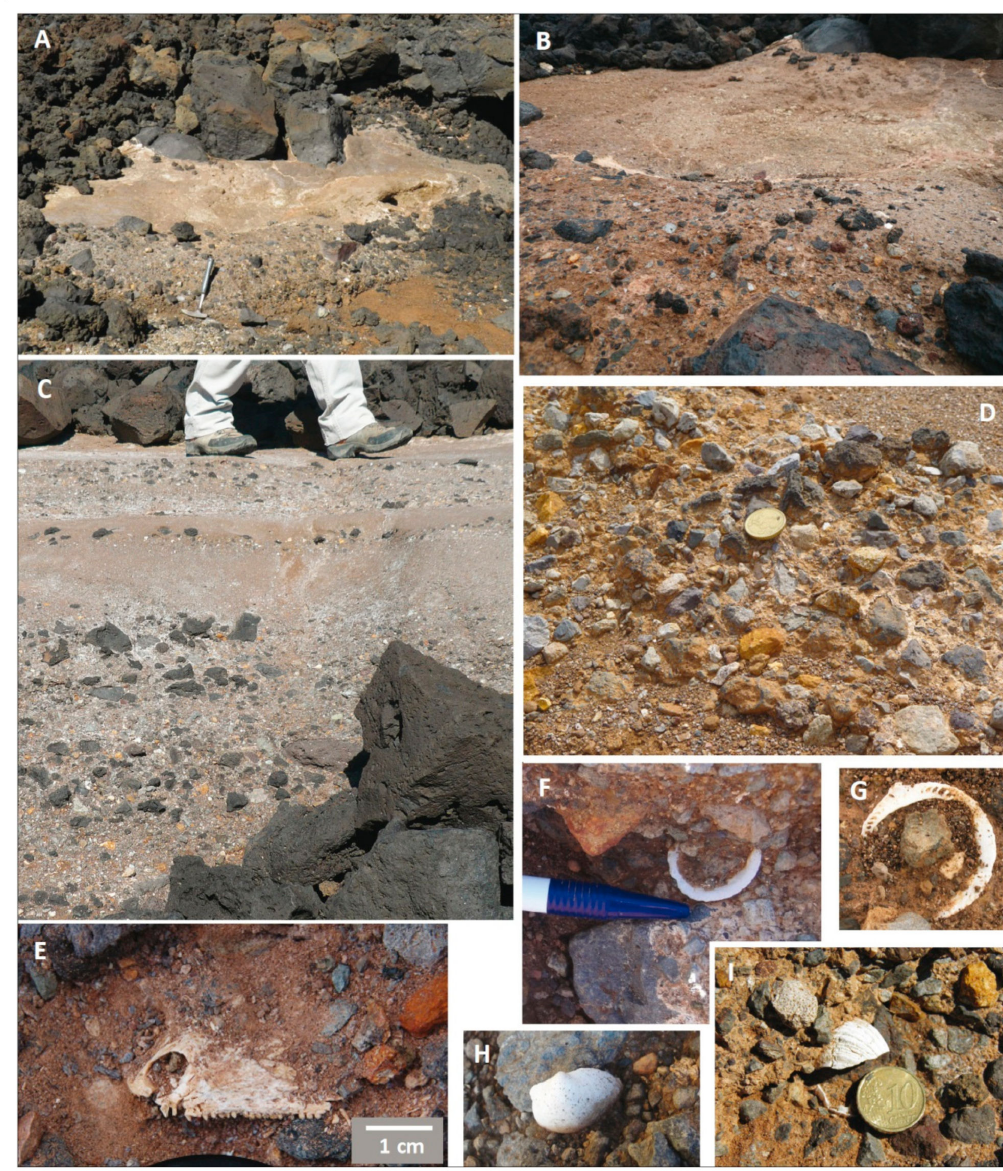
Figure 3. Teno tsunami deposits. ( A – C ) Breccia plastered on in situ basaltic lava close to the seaward edge of the Teno platform, showing normal grading and predominance of pumice in its upper section. The breccia contains abundant larger angular basalt (grey) and smaller light-colored heterolithic clasts dispersed in a sand-sized weathered ash matrix. ( D , I ) Detail of the heterolithic breccia forming the upper unit of the deposit at Teno platform, with matrix to clast-supported fabric, angularity, and poor sorting of clasts, sand-sized ash matrix, heterolithic composition, and fossiliferous